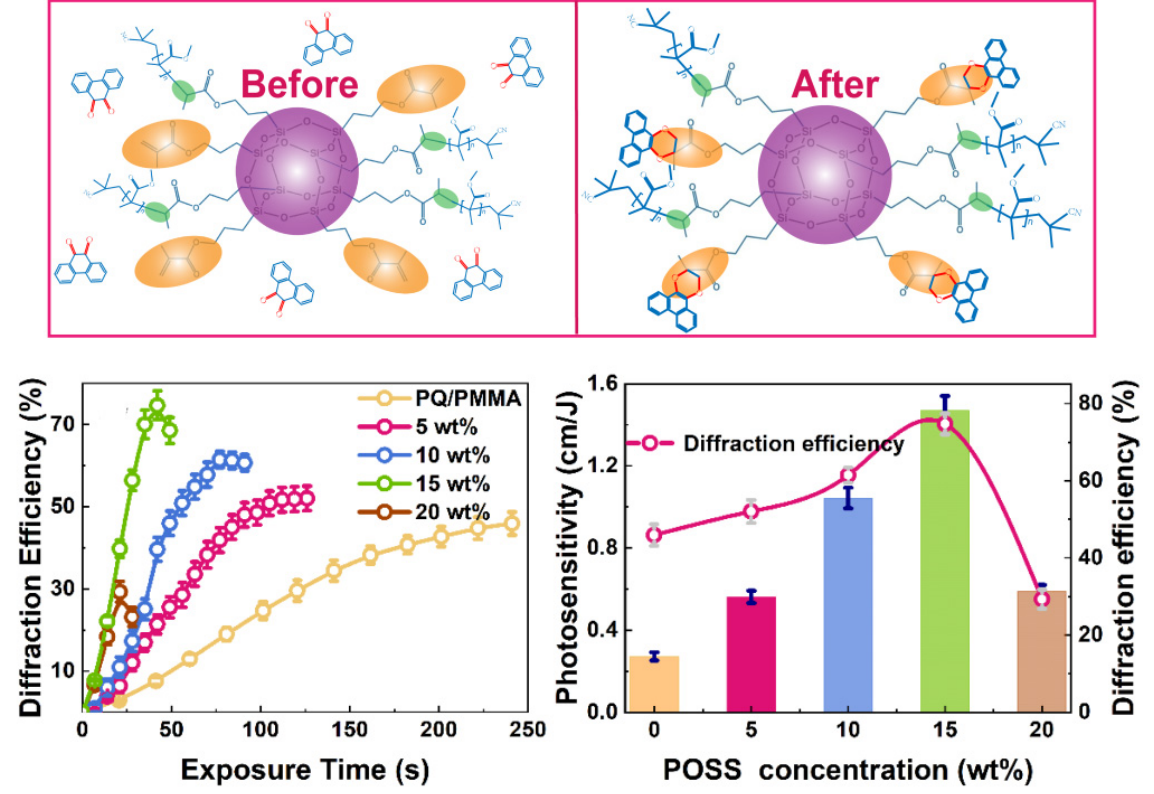
Figure 16. POSS-doped PQ/PMMA reaction mechanism and holographic properties [108] .